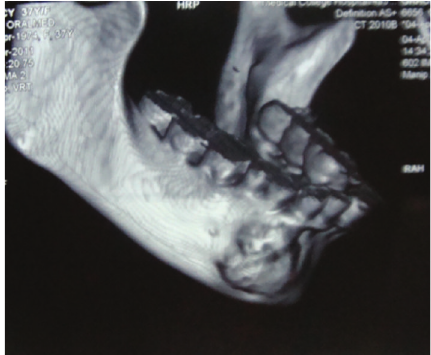
Figure 3: 3D reformatted CT illustrating size and location of the well-defined tumor.